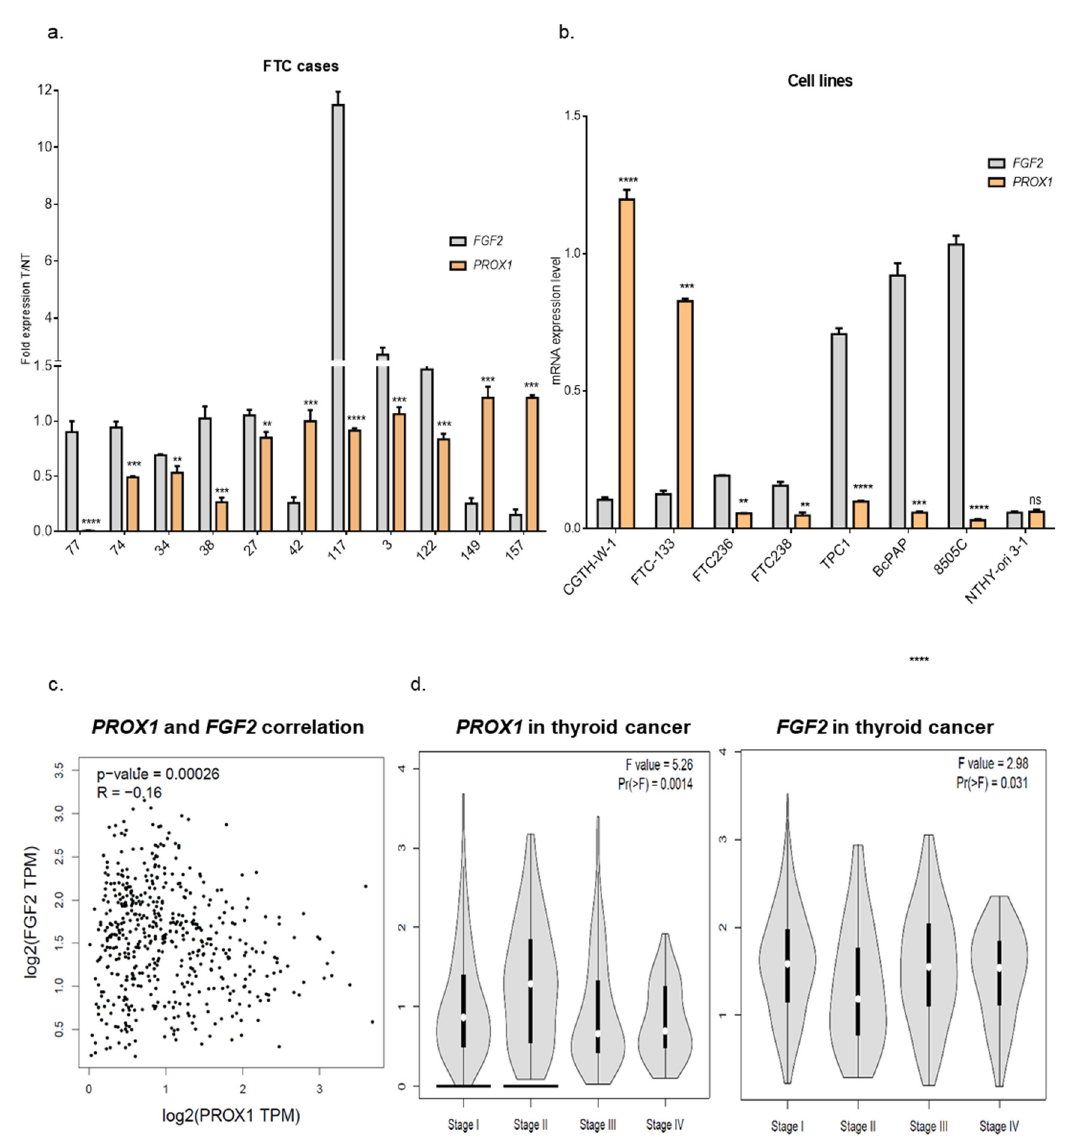
Figure 4. PROX1 expression negatively correlates with FGF2 level in thyroid carcinomas. ( a ) A series of human FTC tissues were analyzed (T/NT) and eight FTC cases show a higher expression of FGF2 compared to PROX1 and three FTC cases (42, 149, and 157) have enhanced expression of PROX1 and reduced level of FGF2. In all tested cases the difference in T/NT ratio between PROX1 and FGF2 was statistically significant (** p < 0.01, *** p < 0.001, **** p < 0.0001) ( b ) PROX1 and FGF2 mRNA expression level in cell lines derived from thyroid carcinomas (SCT derived: CGTH-W-1; FTC-derived: FTC-133, FTC-236, FTC-238; PTC-derived: TPC1, BcPAP; and anaplastic cancer-derived: 8505C) and normal